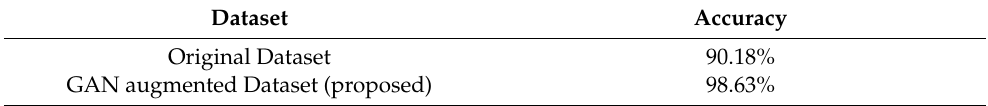
Table 6. Accuracies of original dataset vs. the proposed GAN-augmented